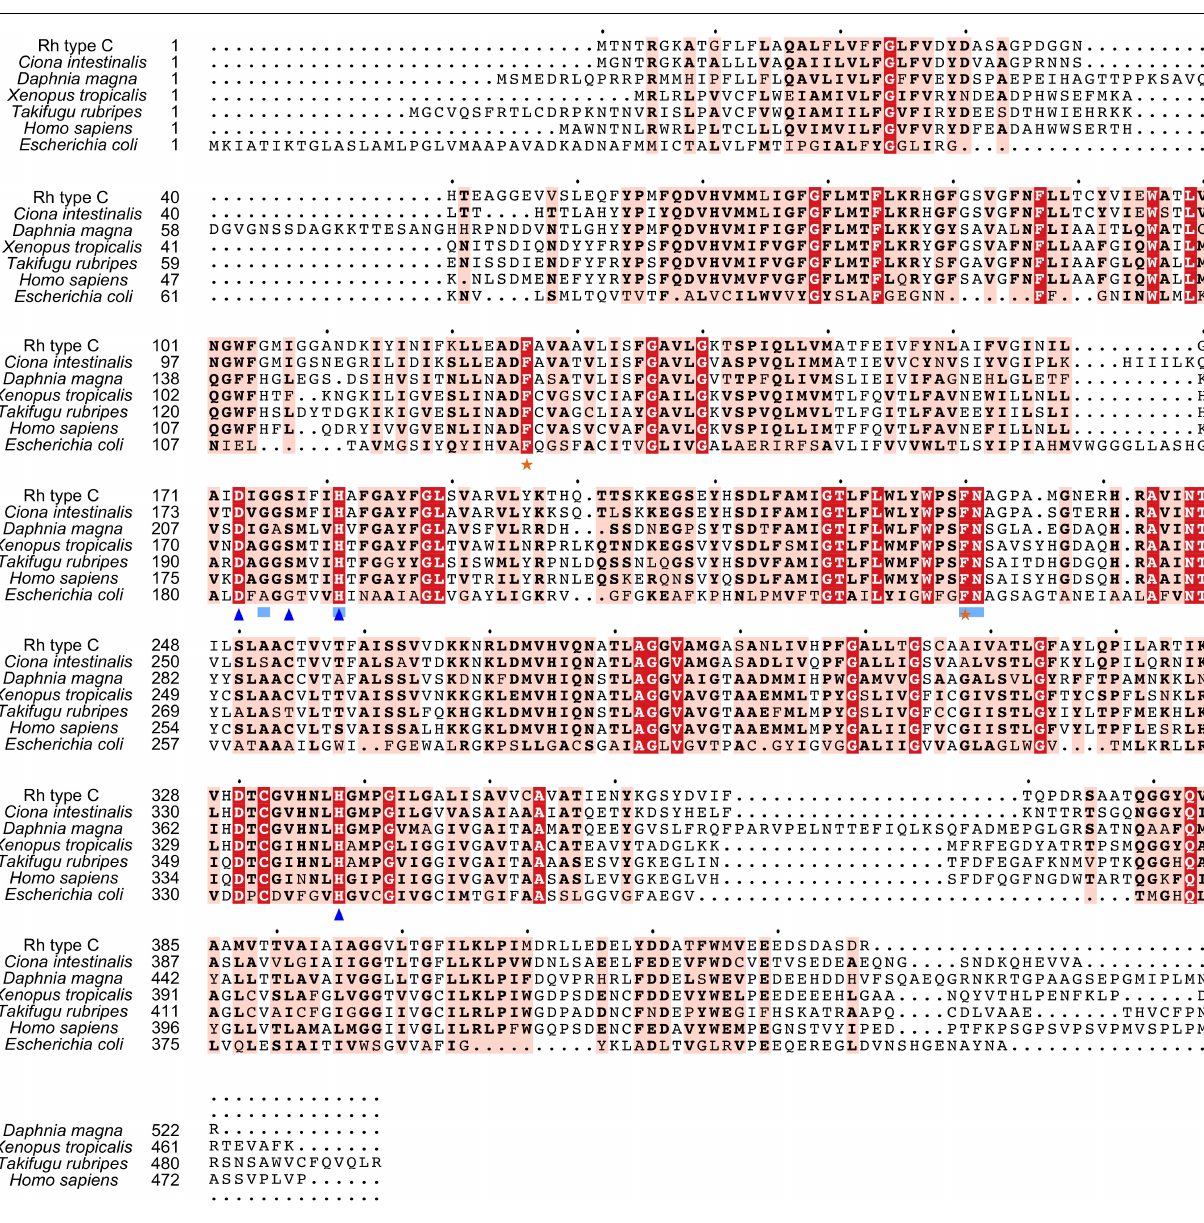
FIGURE 5 | Multiple amino acid alignment of deduced Rh type C of M. manhattensis with E. coli AmtB and corresponding sequences of selected species. Identical amino acid residues are in bold white and filled with red. Strongly similar amino acid residues are in bold black and filled with light red. Phenylalanine gates of the ammonia channel are indicated by black stars. Residues involved in NH 4 + recruitment are indicated by light blue strokes. Residues involved in deprotonation are indicated by blue